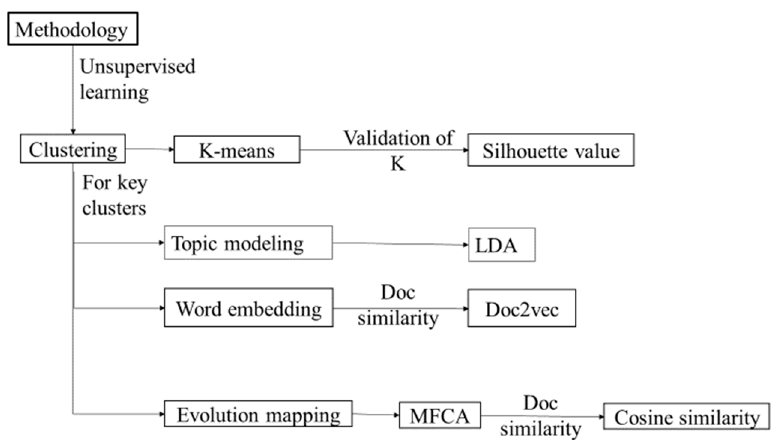
Figure 6. Structure of proposed machine learning methodologies.